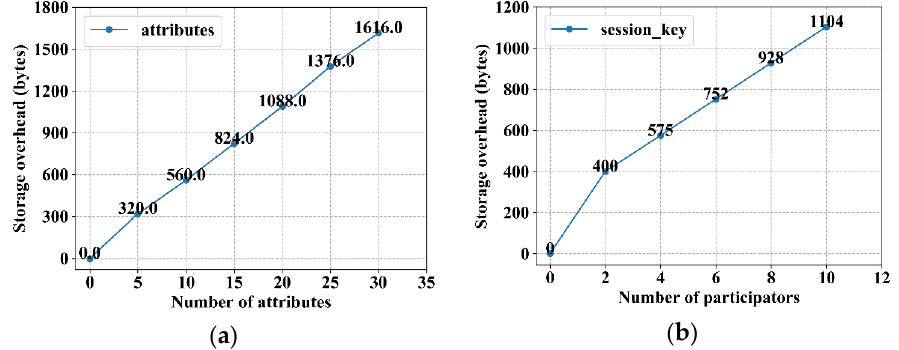
Figure 7. Storage overhead for IoT devices: ( a ) storage overhead of the attributes list; ( b ) storage overhead of the session keys.